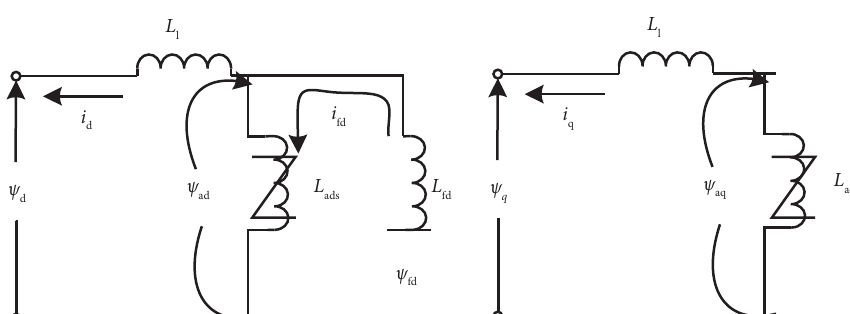
Figure 3: Equivalent circuit diagram of motor magnetic chain and